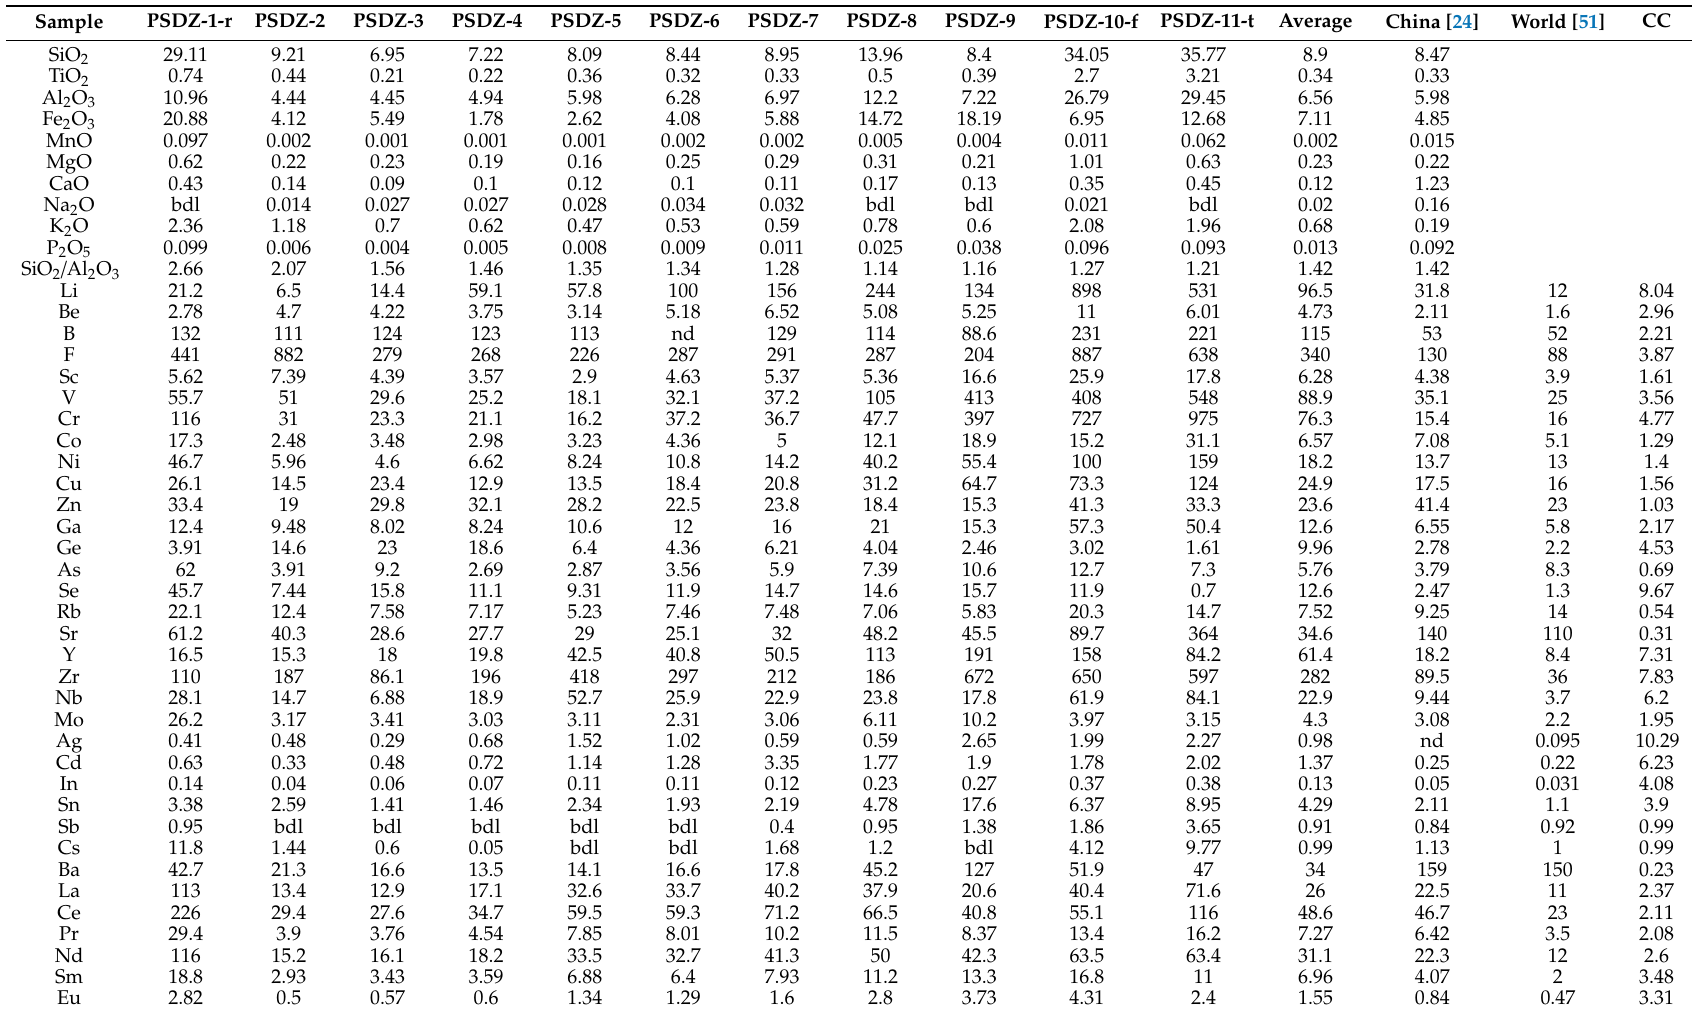
Table 3. Major and trace element concentrations of coal and non-coal samples in the Donggou mine ( µ g / g, coal or bulk rock basis).